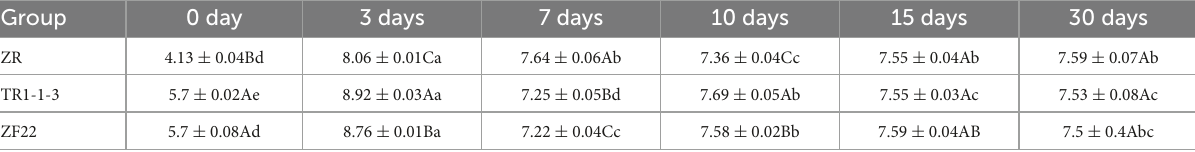
TABLE 4 Bacteriostatic ability of lactic acid bacteria. Strains